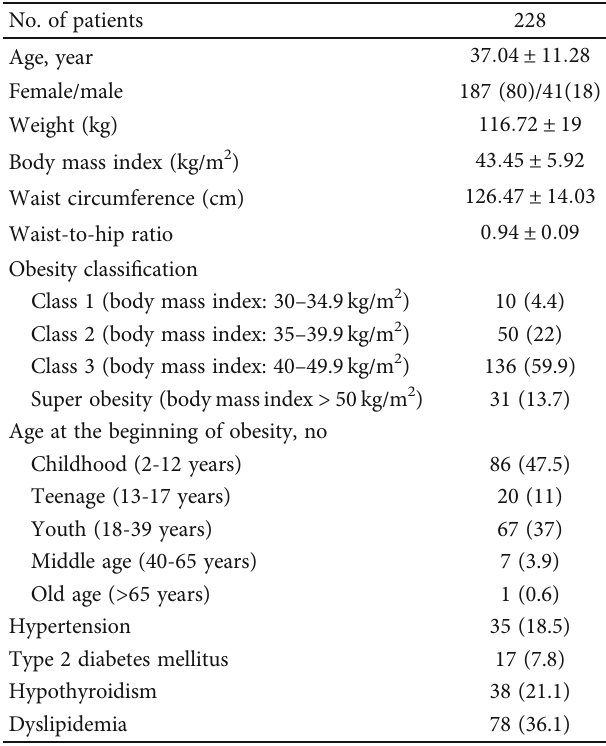
Table 2: Demographic, anthropomorphic, and clinical data of the study